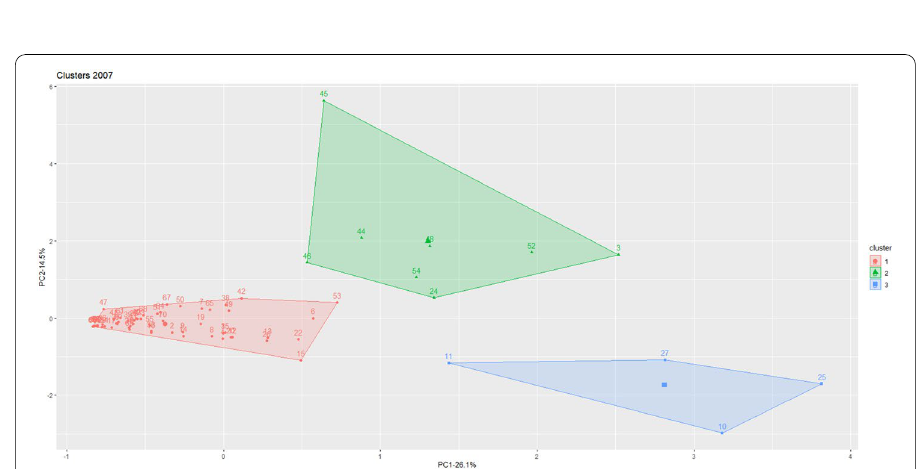
Fig. 5 Clusters of industries, 2007